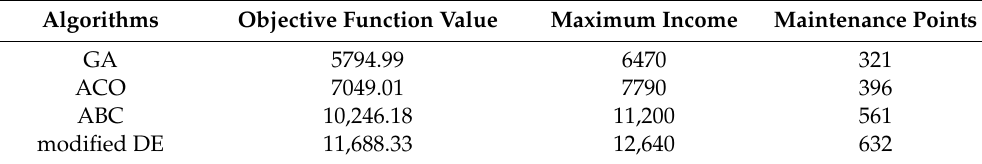
Table 8. Comparison of other